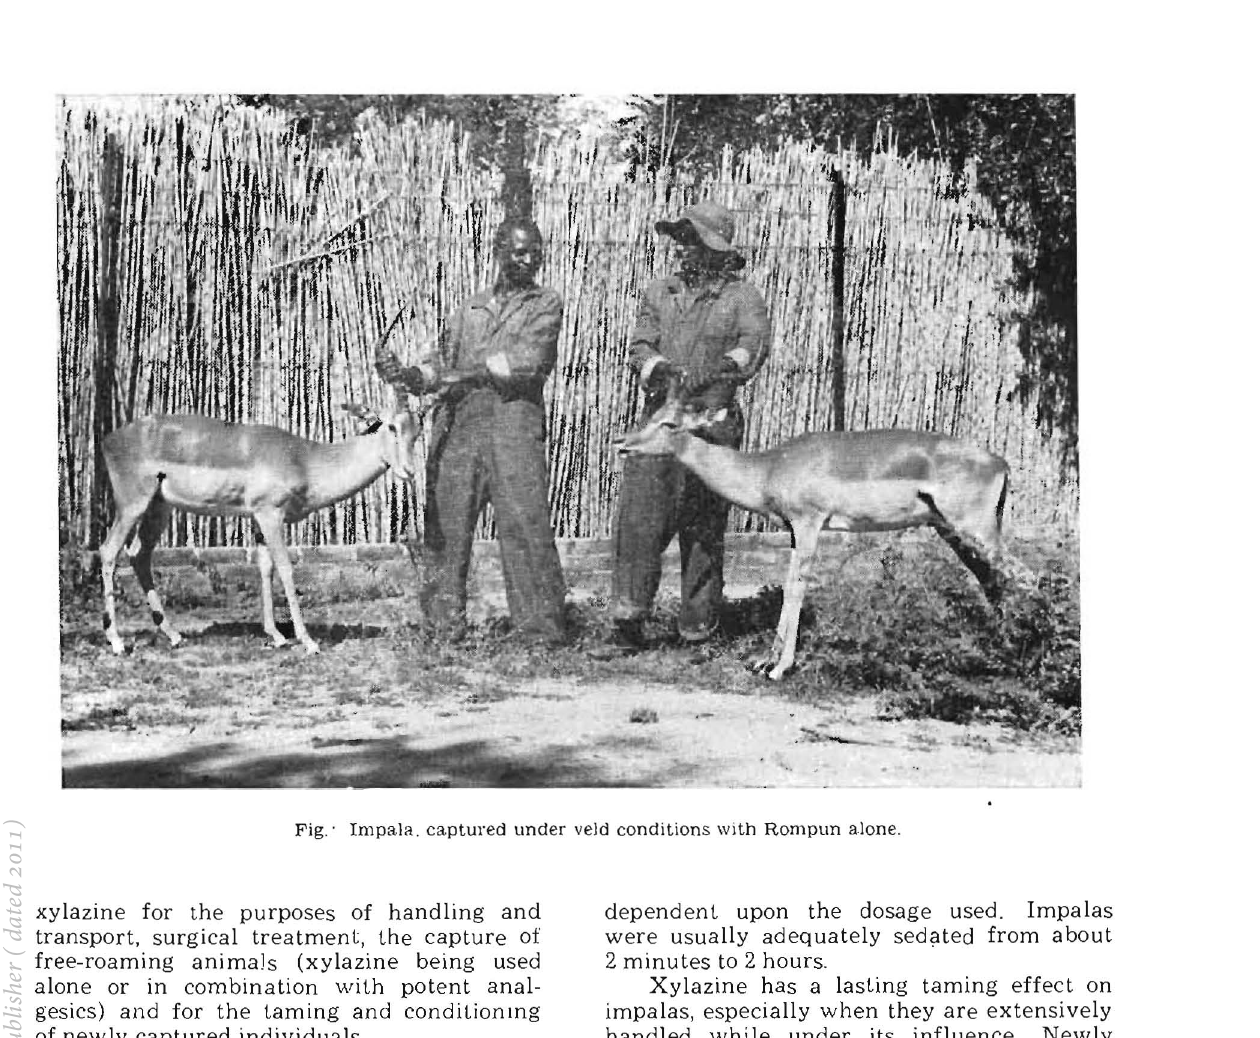
Fig.' Impala. captured under veld conditions with Rompun